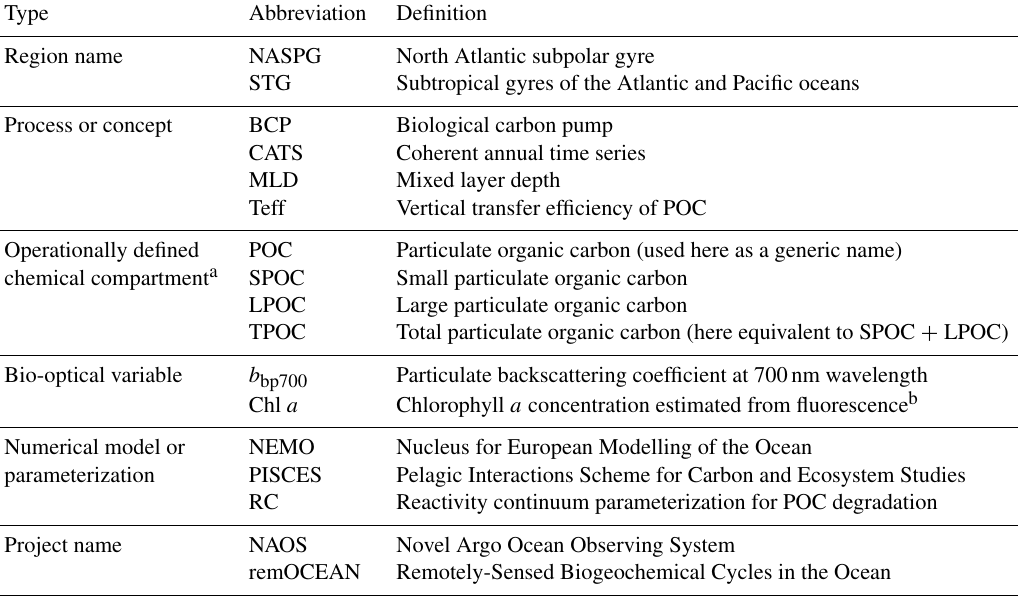
Table 1. List of